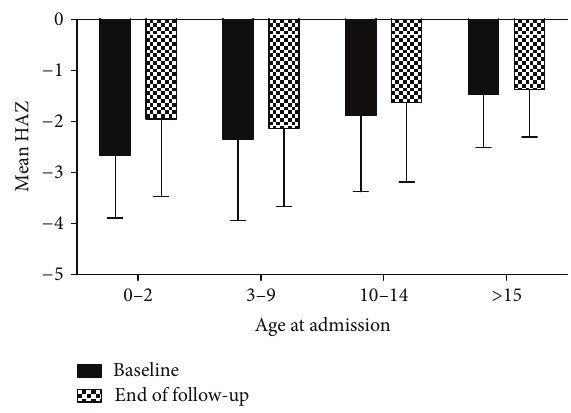
Figure 1: Mean values of height for age 𝑍 score (HAZ) at admission (baseline) and at last follow-up visit (end of follow-up) according to age at admission (expressed in years) for pediatric patients with chronic kidney